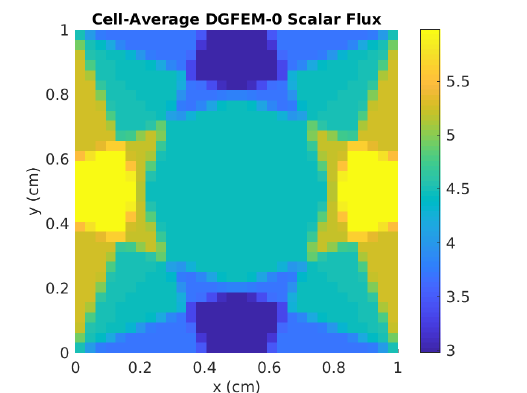
Figure 3: Cell-Average DGFEM-0/pSCT Scalar Flux for MMS-Derived Problem with Discontinuous